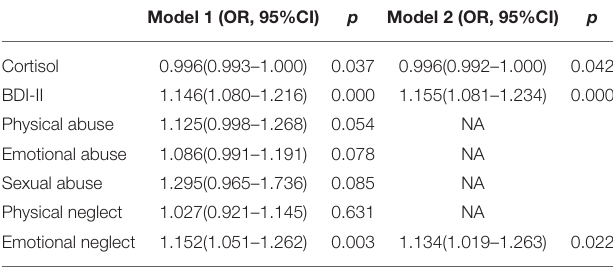
TABLE 6 | Logistic regression of the variables with